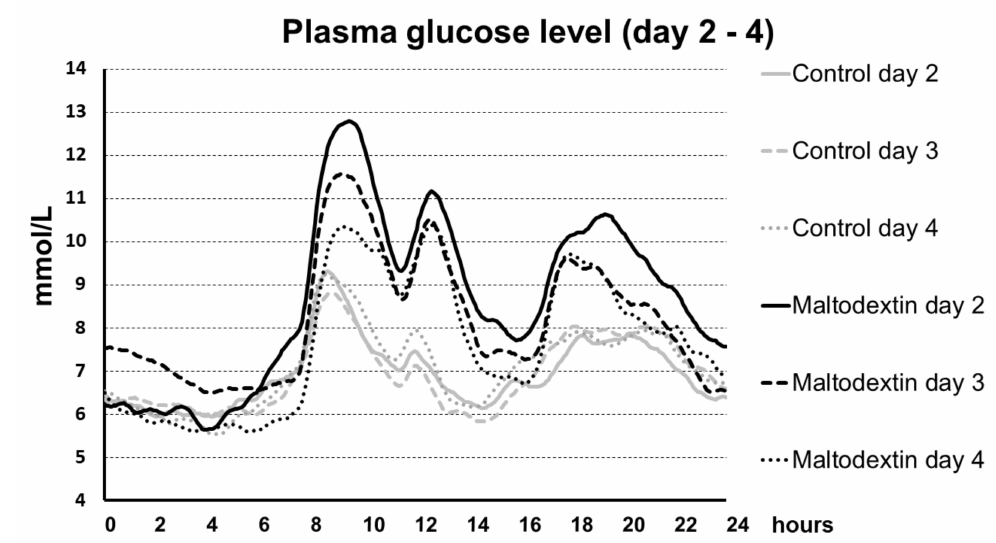
Figure 1. Plasma glucose level during day 2, 3, and 4 in T2DM patients during control period and during maltodextrin administration.